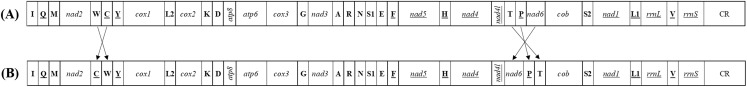
The mitochondrial gene arrangements detected from (A) Achilidae, Flatidae, Fulgoridae, Flatidae, Issidae and Ricaniidae and (the putative ancestral arthropod) and (B) Delphacidae.Arrows indicate the rearrangements of genes or gene clusters.